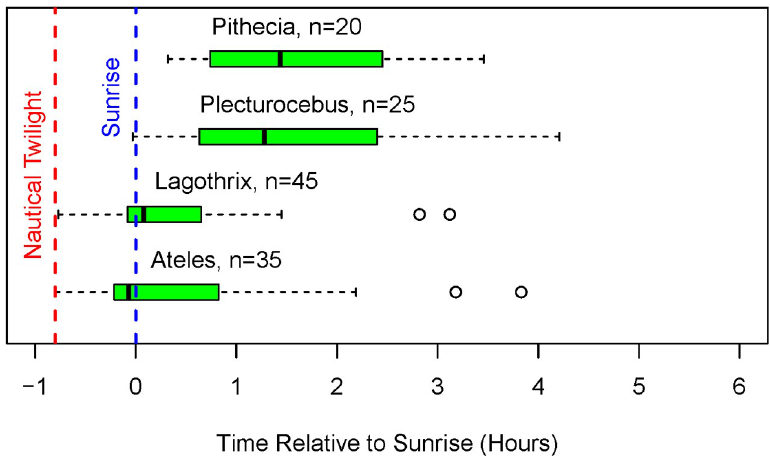
Fig 4. Time of first movement from the sleeping tree (hours relative to sunrise). Boxplots: median and interquartile range (IQR); whiskers indicate extreme values unless there are data points more than 1.5 � IQR below the lower quartile or more than 1.5 � IQR above the upper quartile, in which case whiskers stop at the first data points within those boundaries and open circles indicate more extreme points. n = number of